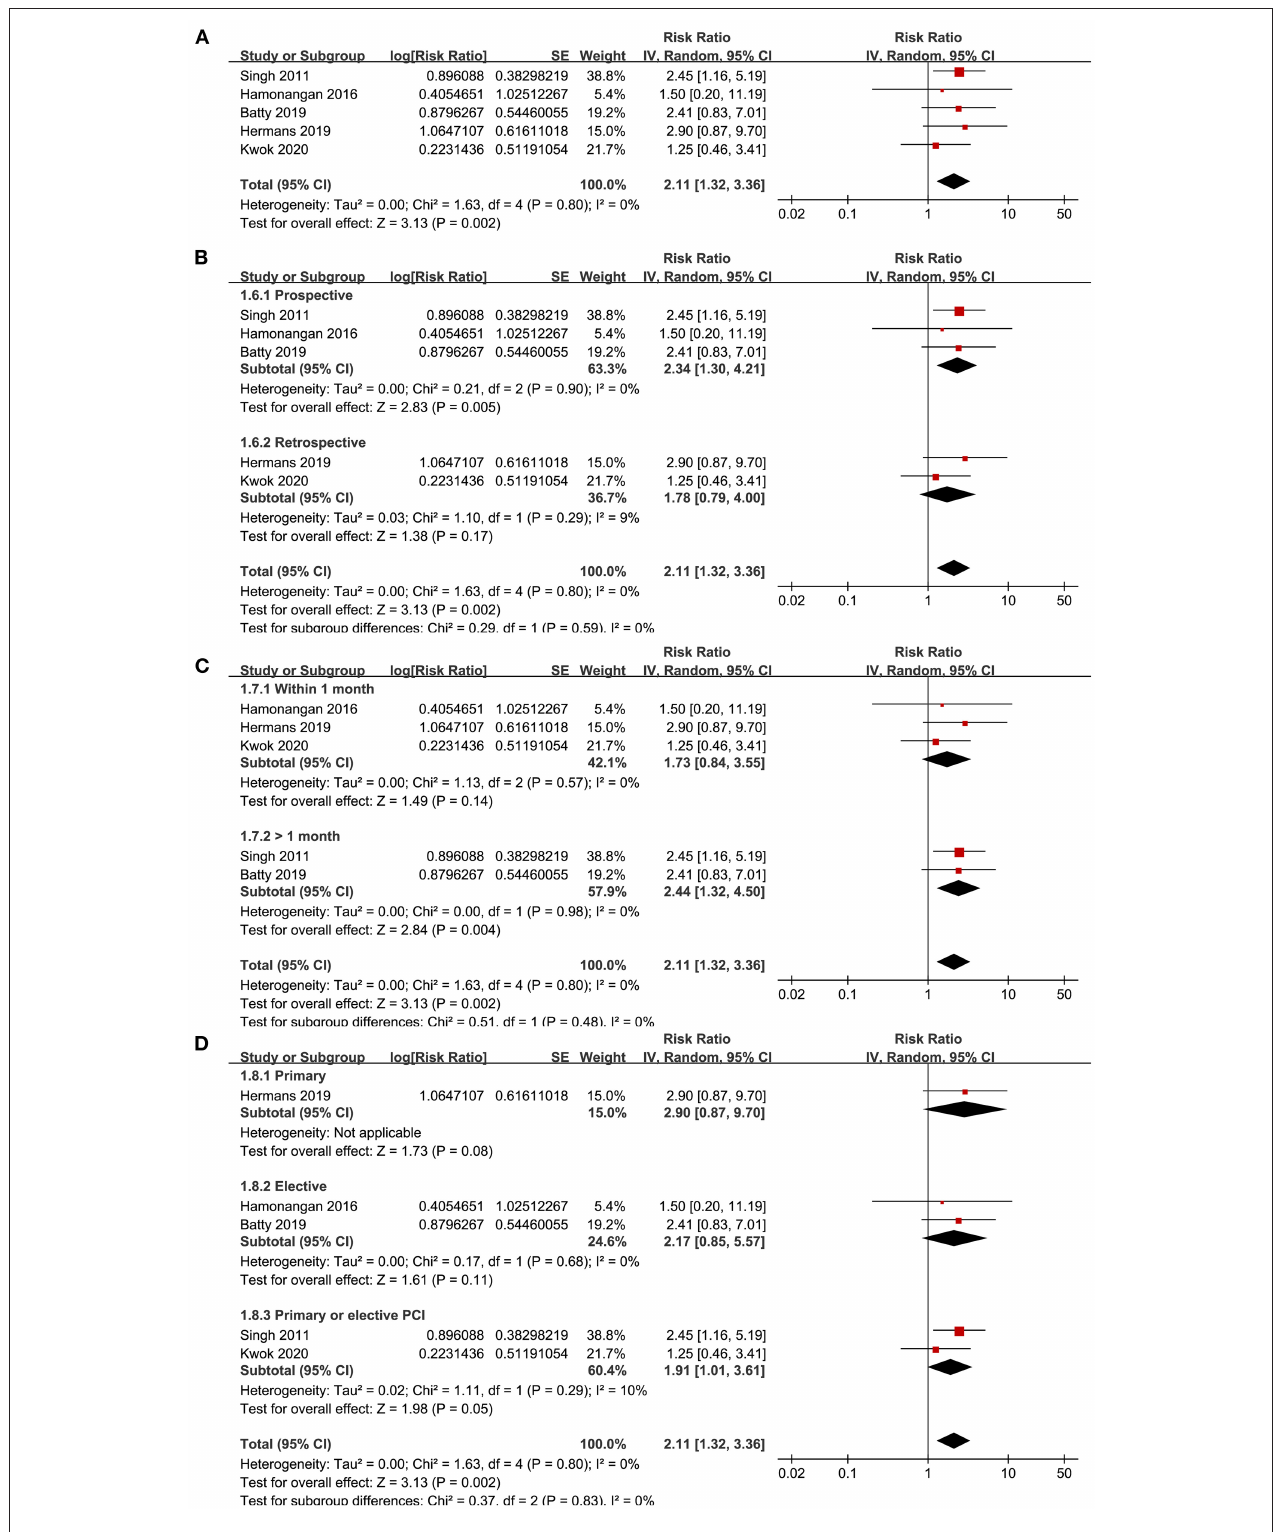
FIGURE 3 | Forest plots for the meta-analysis concerning the association between frailty and risk of MACEs after PCI; (A) , Overall meta-analysis; (B) , Subgroup analysis according to study design; (C) , Subgroup analysis according to follow-up duration; and (D) , Subgroup analysis according to the type of PCI.